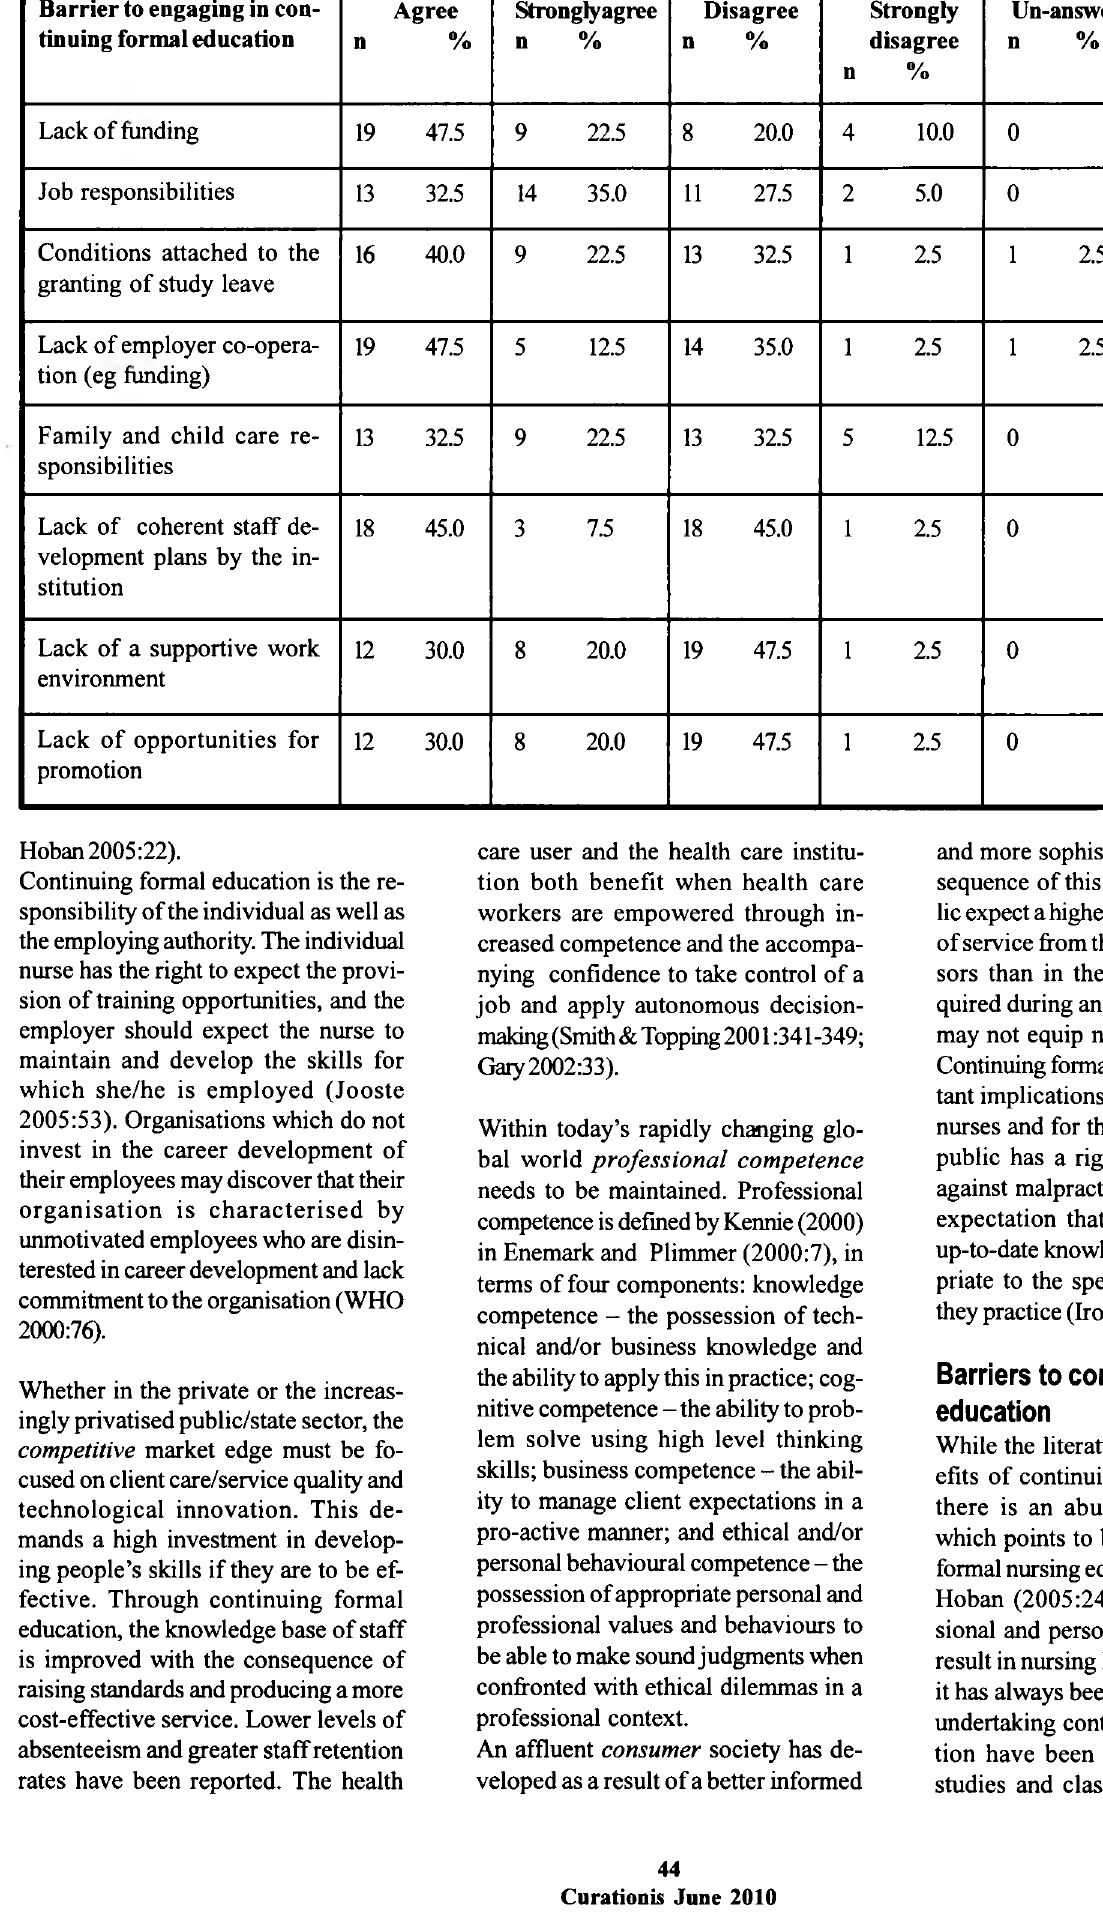
Table 3 : Barriers to engaging in continuing formal education (N=40) Barrier to engaging in